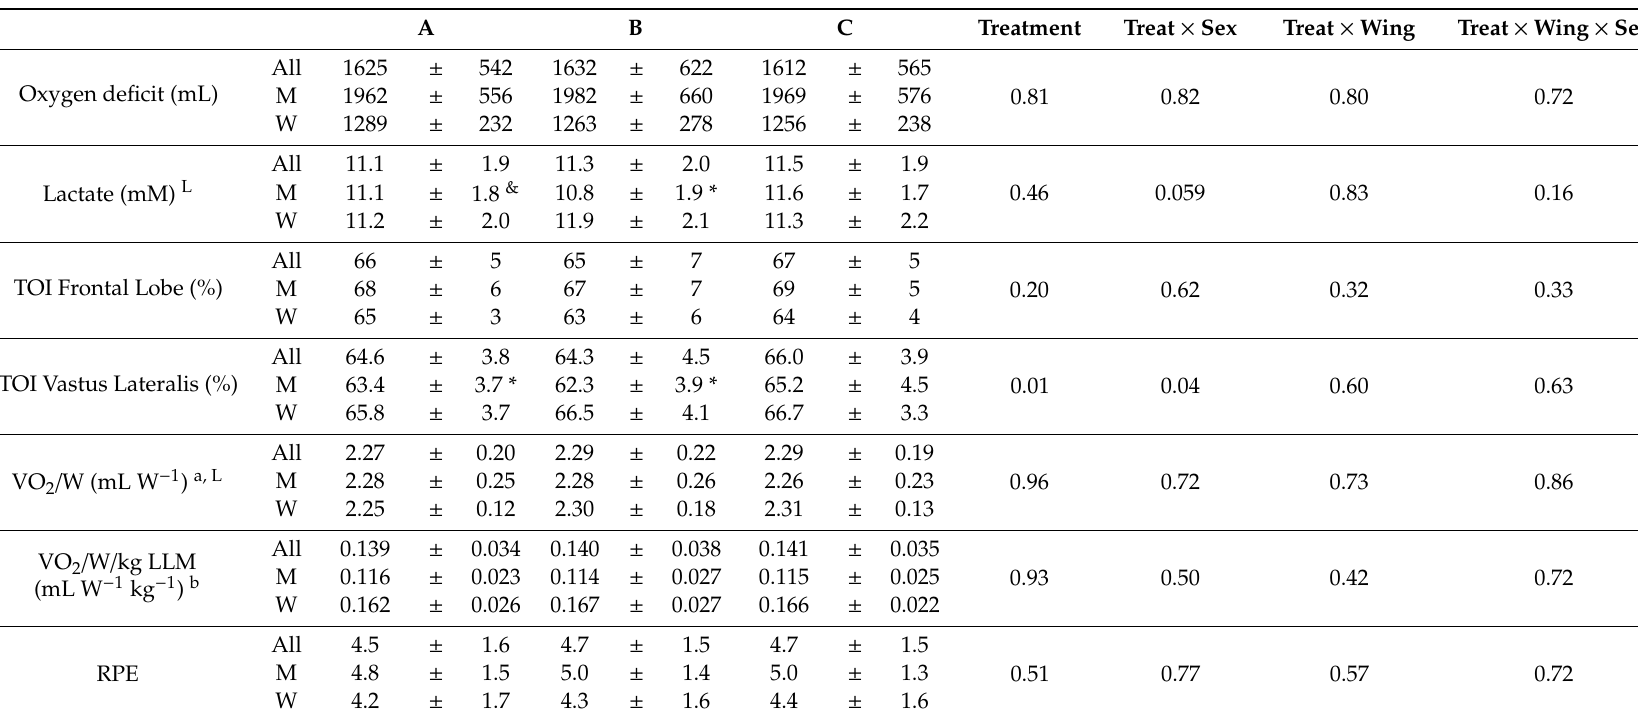
Table 3. Oxygen deficit, brain and muscle oxygenation, VO 2 per watt and rate of perceived exertion for the first three 30 s Wingate tests (mean ± SD). A B C Treatment Treat × Sex Treat × Wing Treat × Wing × Sex All Oxygen deficit (mL)